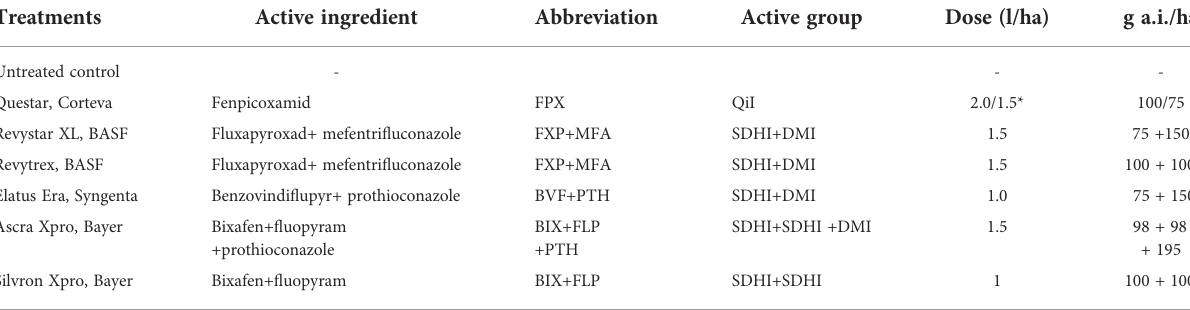
TABLE 2 Treatment mixtures and fenpicoxamid at full label doses from trials carried out in 2021.